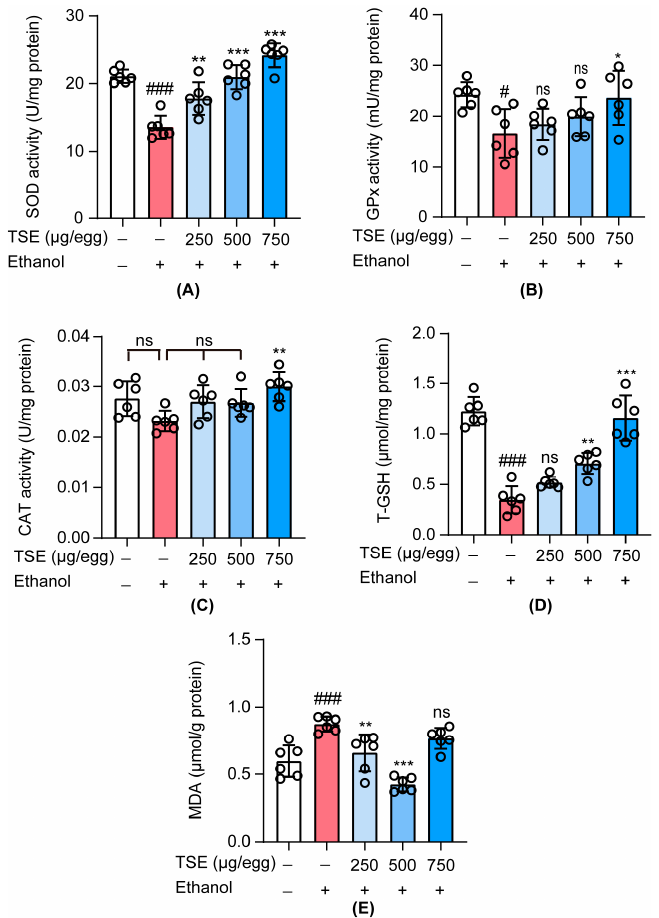
Figure 6. The antioxidant effect of TSE on ethanol-induced chicken embryo liver damage. ( A – E ) are the effects of TSE on the changes of ethanol-induced ( A ) SOD, ( B ) GPx, ( C ) CAT, ( D ) T-GSH, and ( E ) MDA levels in ethanol-induced chicken embryo liver, n = 6 biologically independent samples. Data represent the mean ± standard deviation and significant differences were analyzed by one-way ANOVA. # p < 0.05, ### p < 0.001 vs. control group; * p < 0.05, ** p < 0.01, *** p < 0.001 vs. ethanol group; ns, not significant vs. ethanol group.